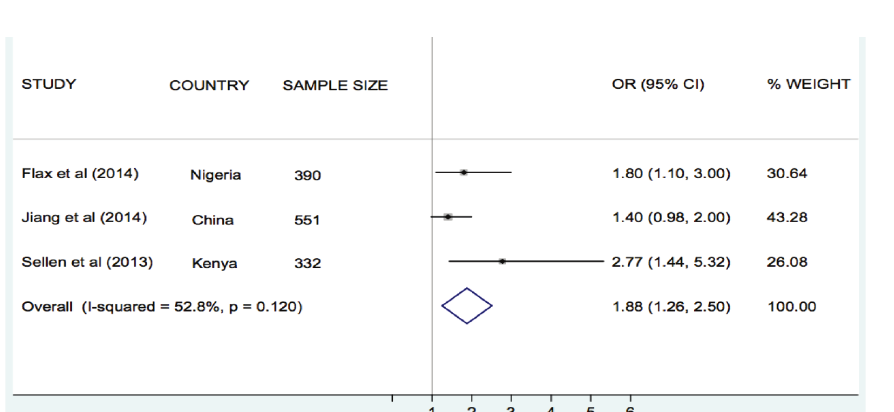
Figure 4. Meta–analysis of the effect of SMS/cell phone intervention vs routine prenatal care on onset of lactation within three days after birth based on two RCT undertaken in Nigeria and Kenya: OR represents the odds ratio of effect.